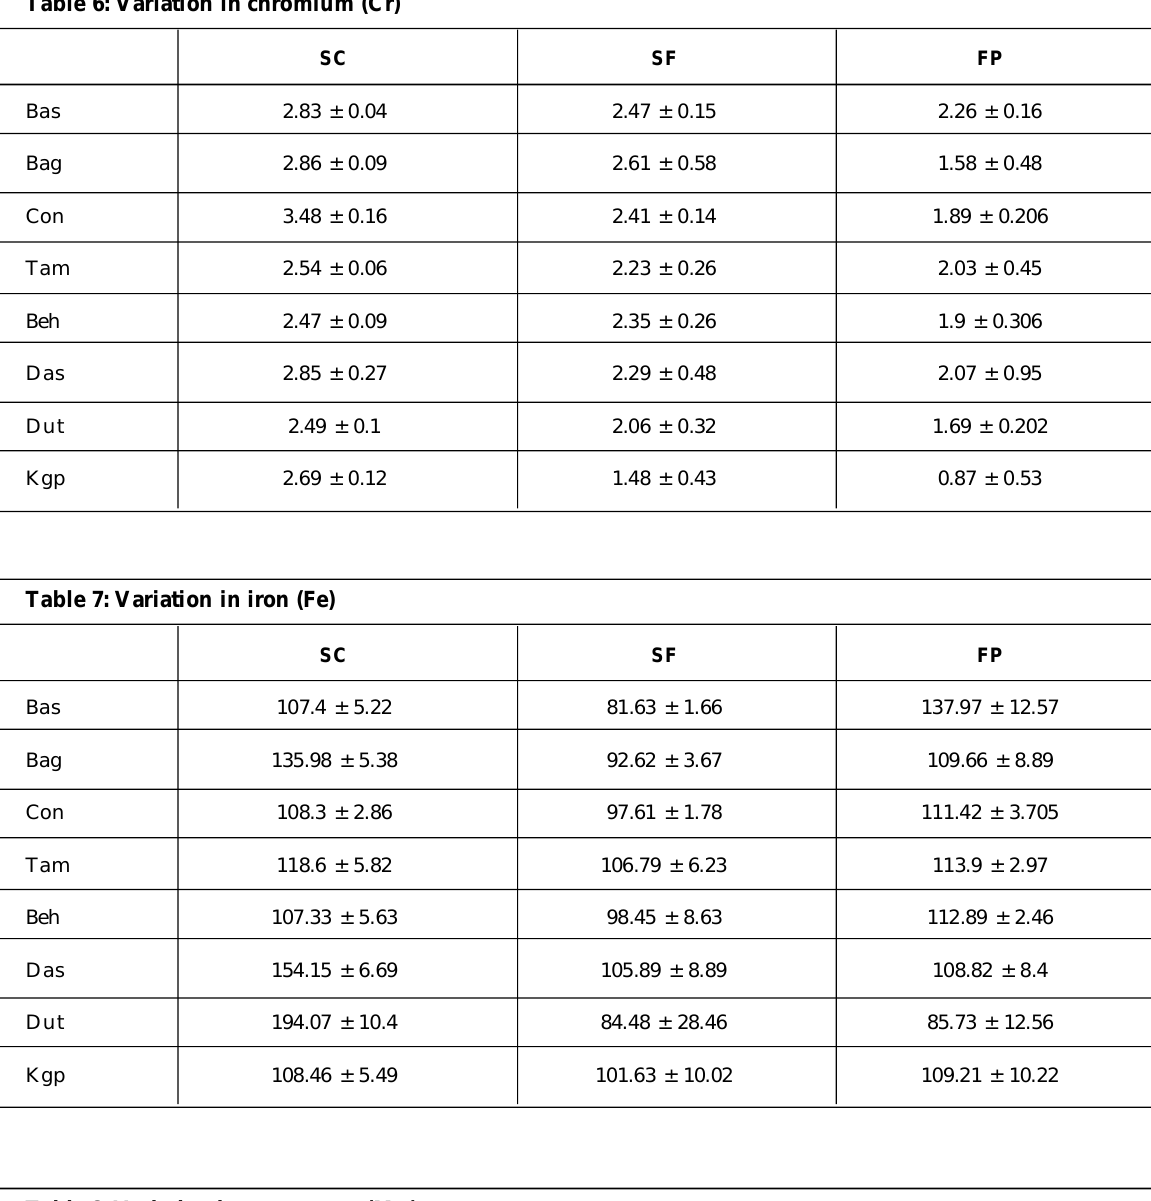
Table 8: Variation in manganese (Mn)